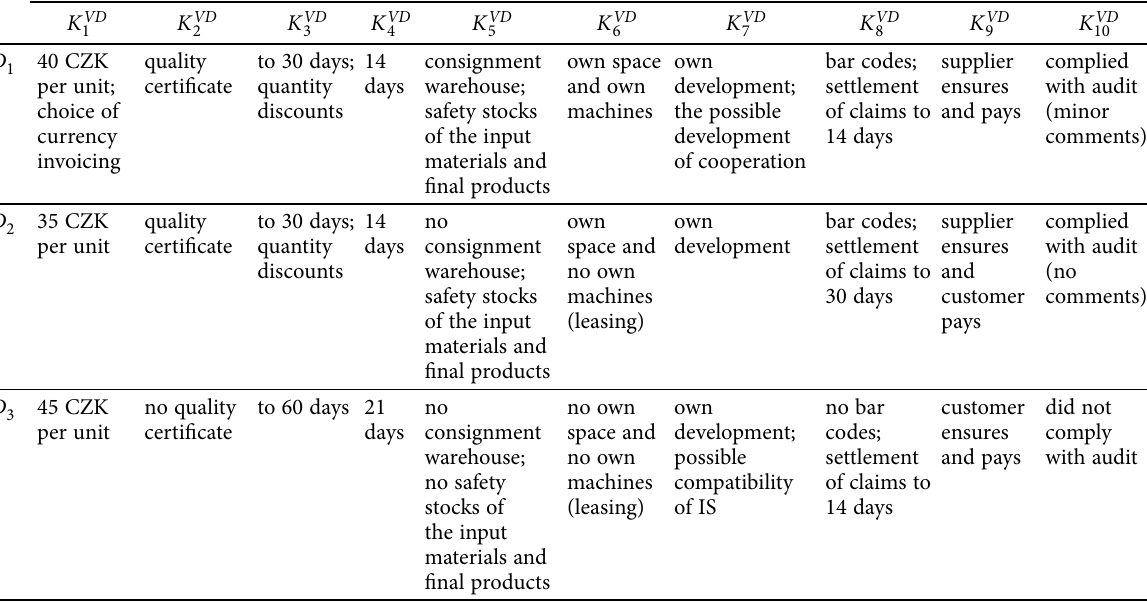
Table 3. The criteria matrix for supplier selection